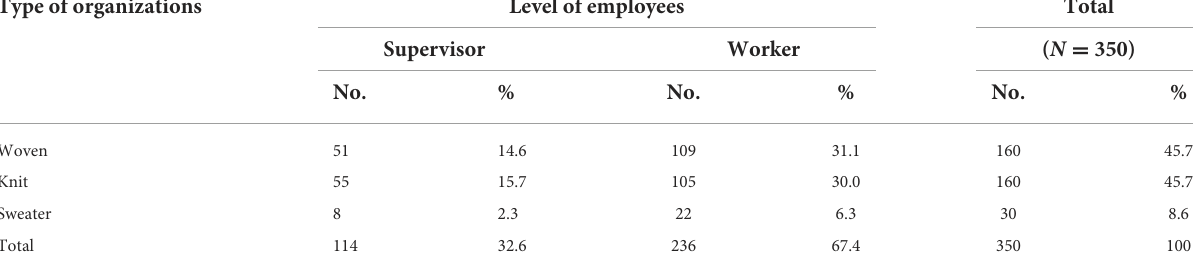
TABLE 2 Sample distribution according to type of organizations and level of employees ( N =